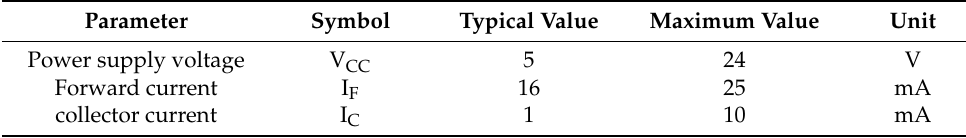
Table 3. Parameters of optocoupler switch.